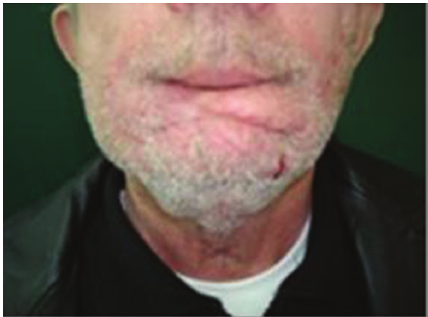
Figure 6: Final result 1 year